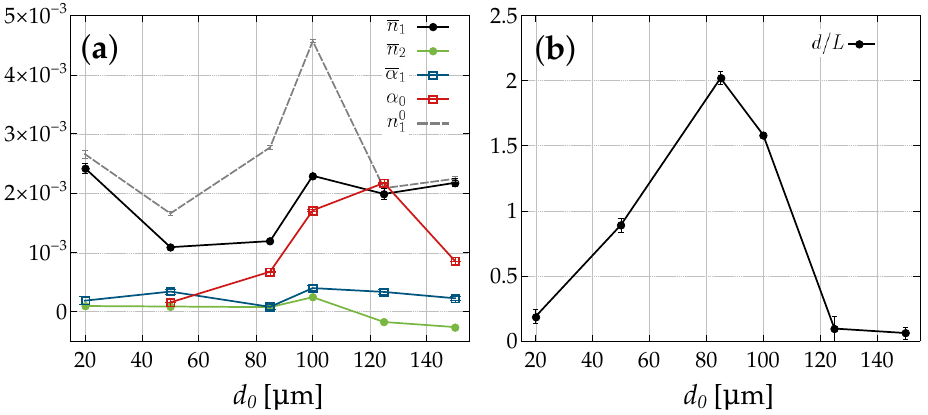
and ( b ) the thickness 1